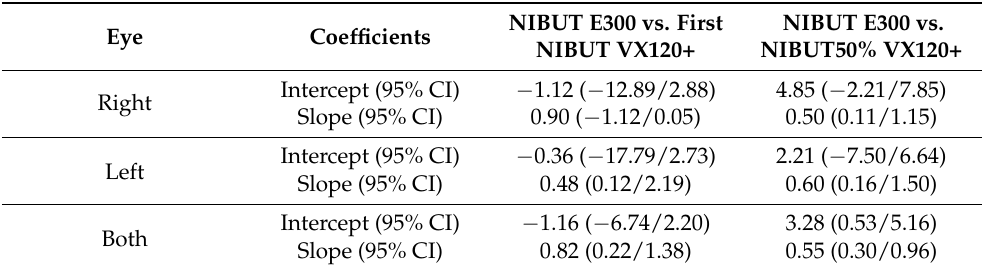
Table 2. Passing–Bablok regression coefficients for the agreement of non-invasive tear break-up time (NIBUT) outcomes between Medmont E300 and Visionix VX120+.